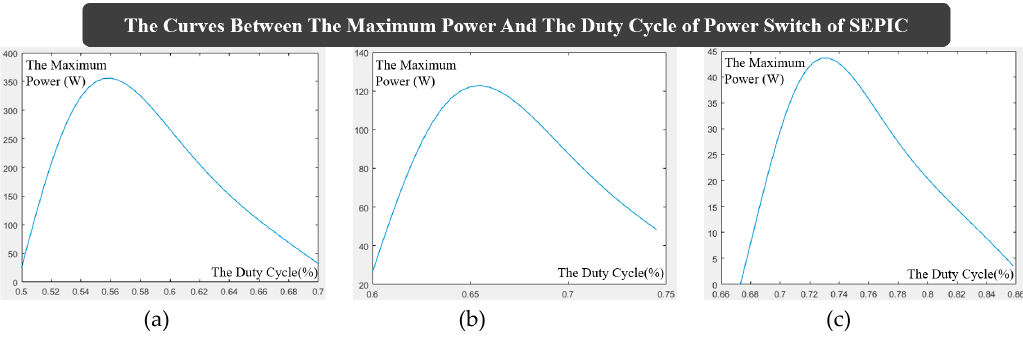
Figure 13. WECS simulation modeling flow chart